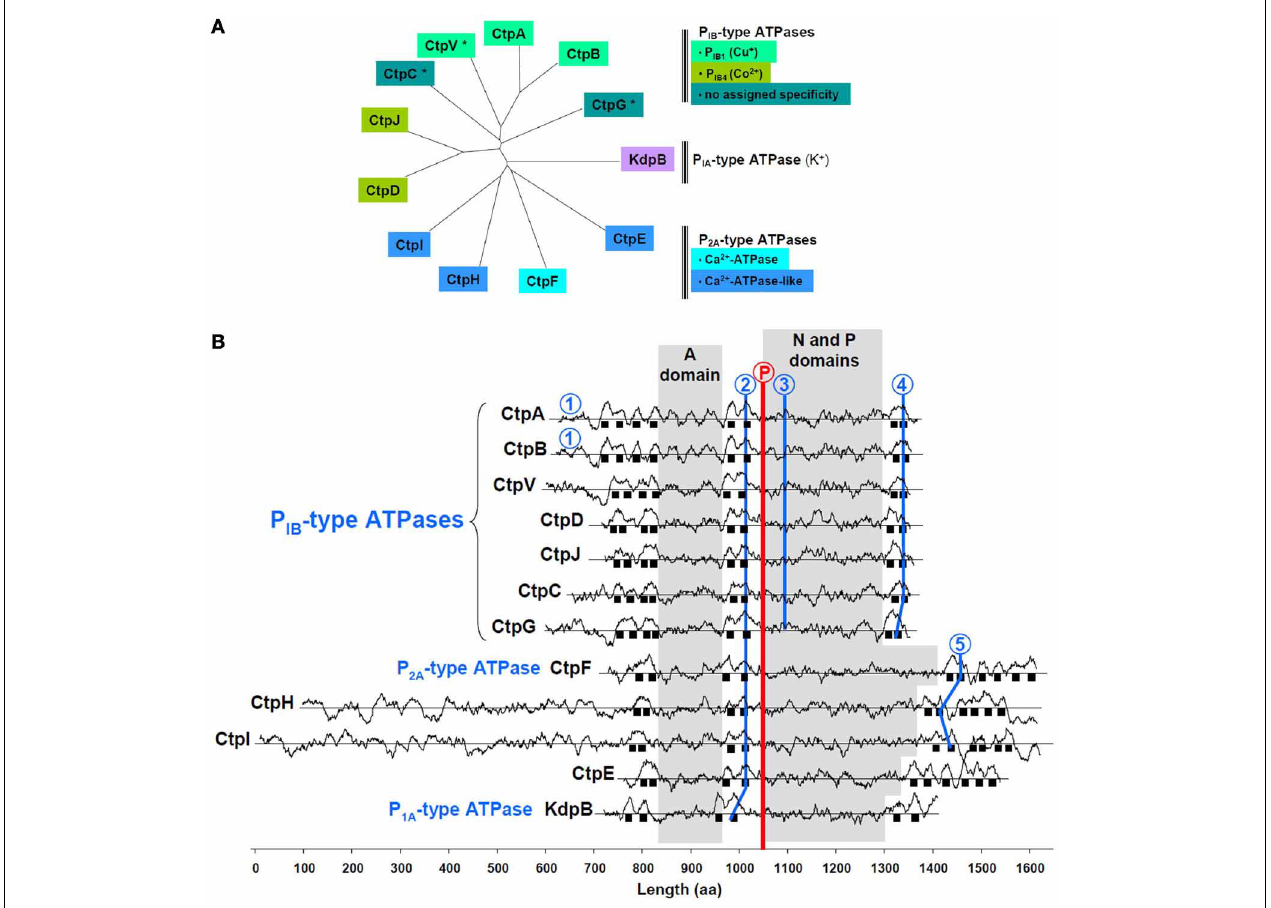
FIGURE 1 | Main feature of M. tuberculosis P-type ATPases. (A) Sequences were aligned with ClustalW and organized in an unrooted tree using TreeView; ∗ , indicates the presence of a gene that could encode a metallochaperone, upstream the P-type ATPase encoding gene. (B) Hydrophobicity profiles are shown for the 12 P-type M. tuberculosis ATPases. Sequences are aligned on the phosphorylation motif (encircled P in red); black squares represent membrane spanning helices. Ion-binding motifs in P 1B -type ATPases: 1, Cys-X 2 -Cys;